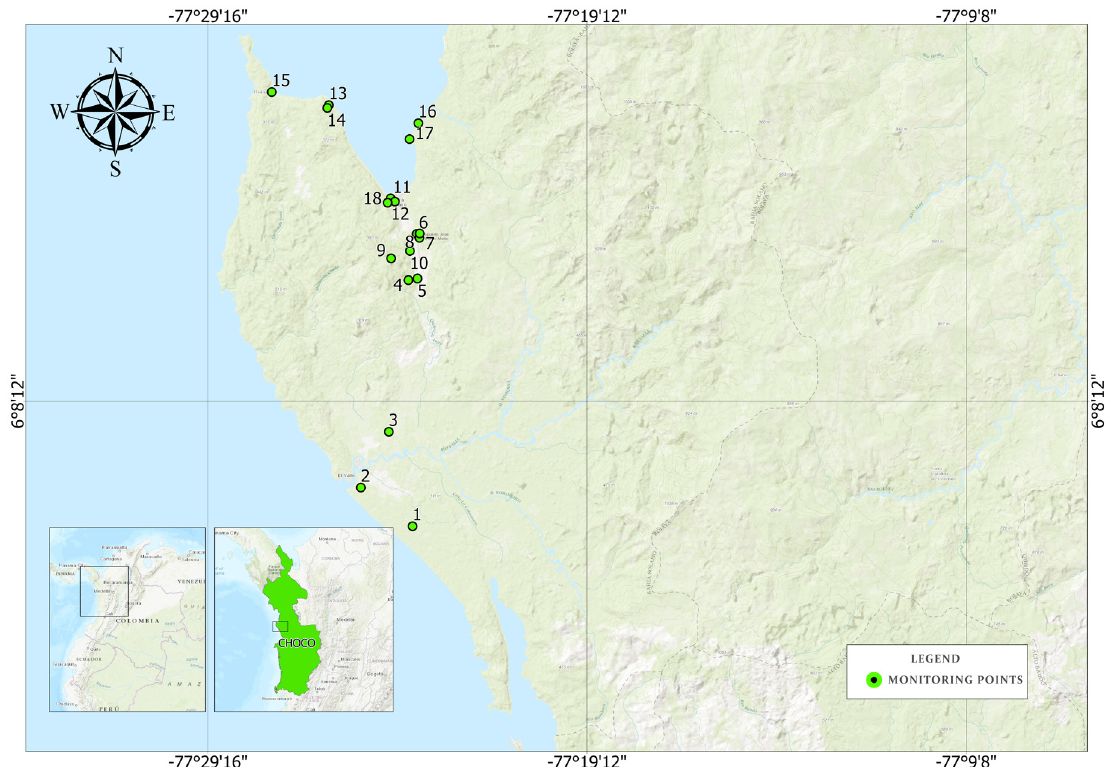
Figure 1. Sampling sites in Bahia Solano Municipality. Site numbers correspond to data presented in Table